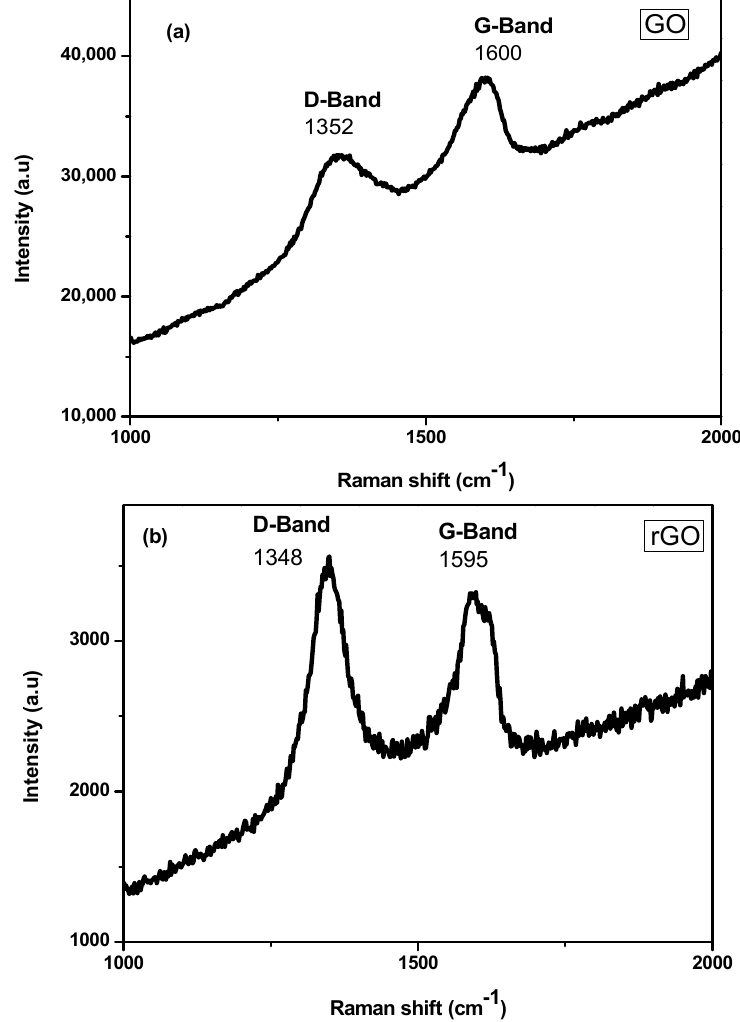
Figure 2. Raman Spectra of ( a ) graphene oxide (GO) ( b ) reduced graphene oxide (rGO).